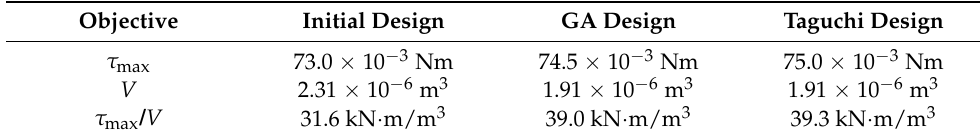
Table 6. Simulation results of GA and Taguchi optimization.